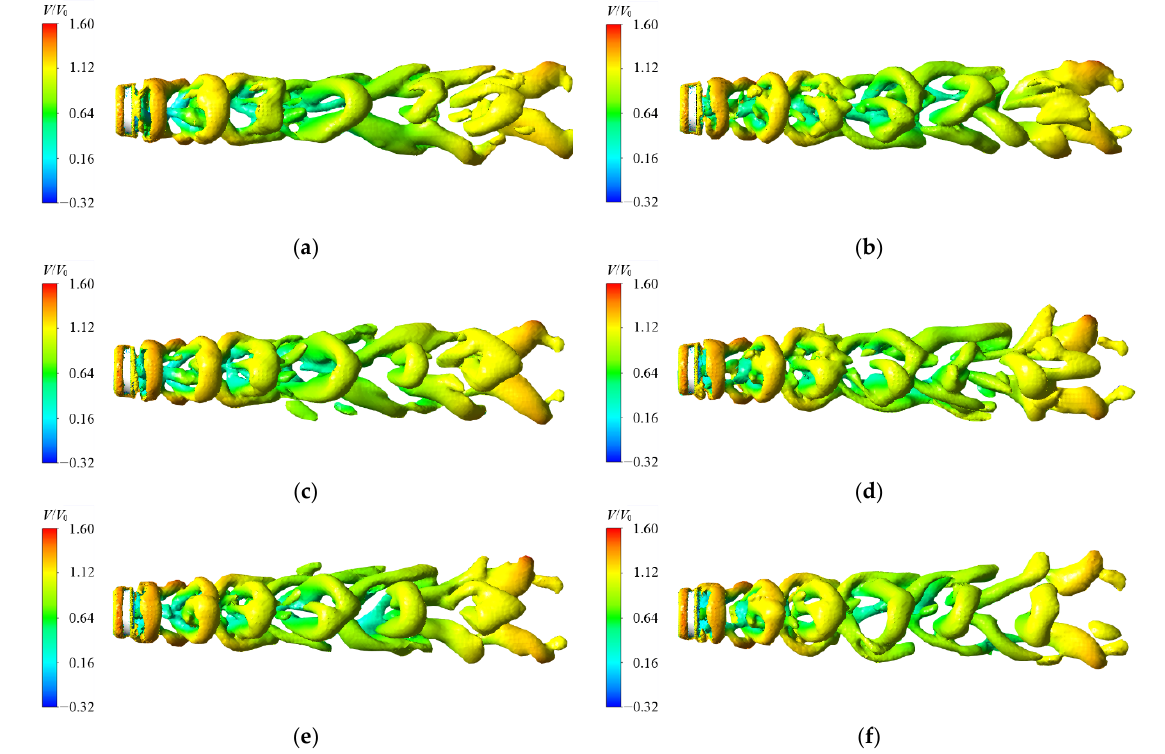
Figure 17. Vorticity Iso-surfaces colored by velocity for the two configurations: ( a ) DT for TSR = 3.0; ( b ) RDT for TSR = 3.0; ( c ) DT for TSR = 4.0; ( d ) RDT for TSR = 4.0; ( e ) DT for TSR = 5.0; ( f ) RDT for TSR = 5.0.